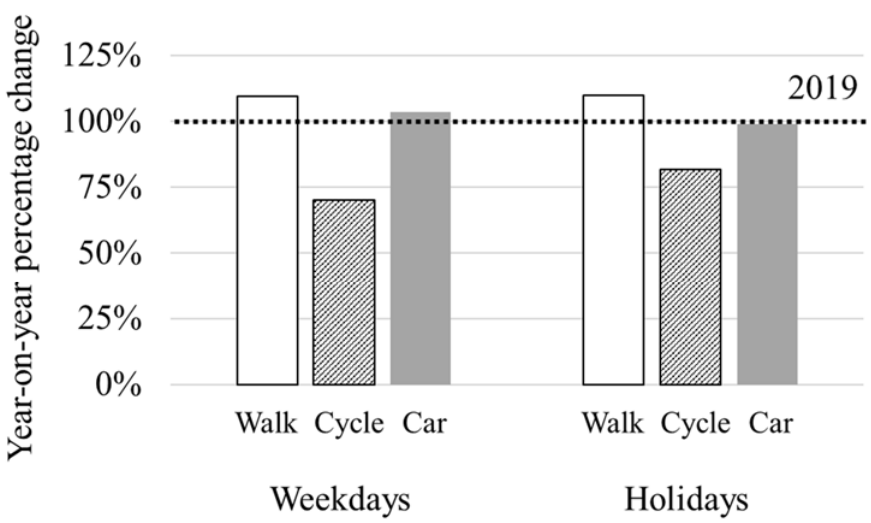
Figure 6. Percentage change by means of travel in 2020 compared to 2019.